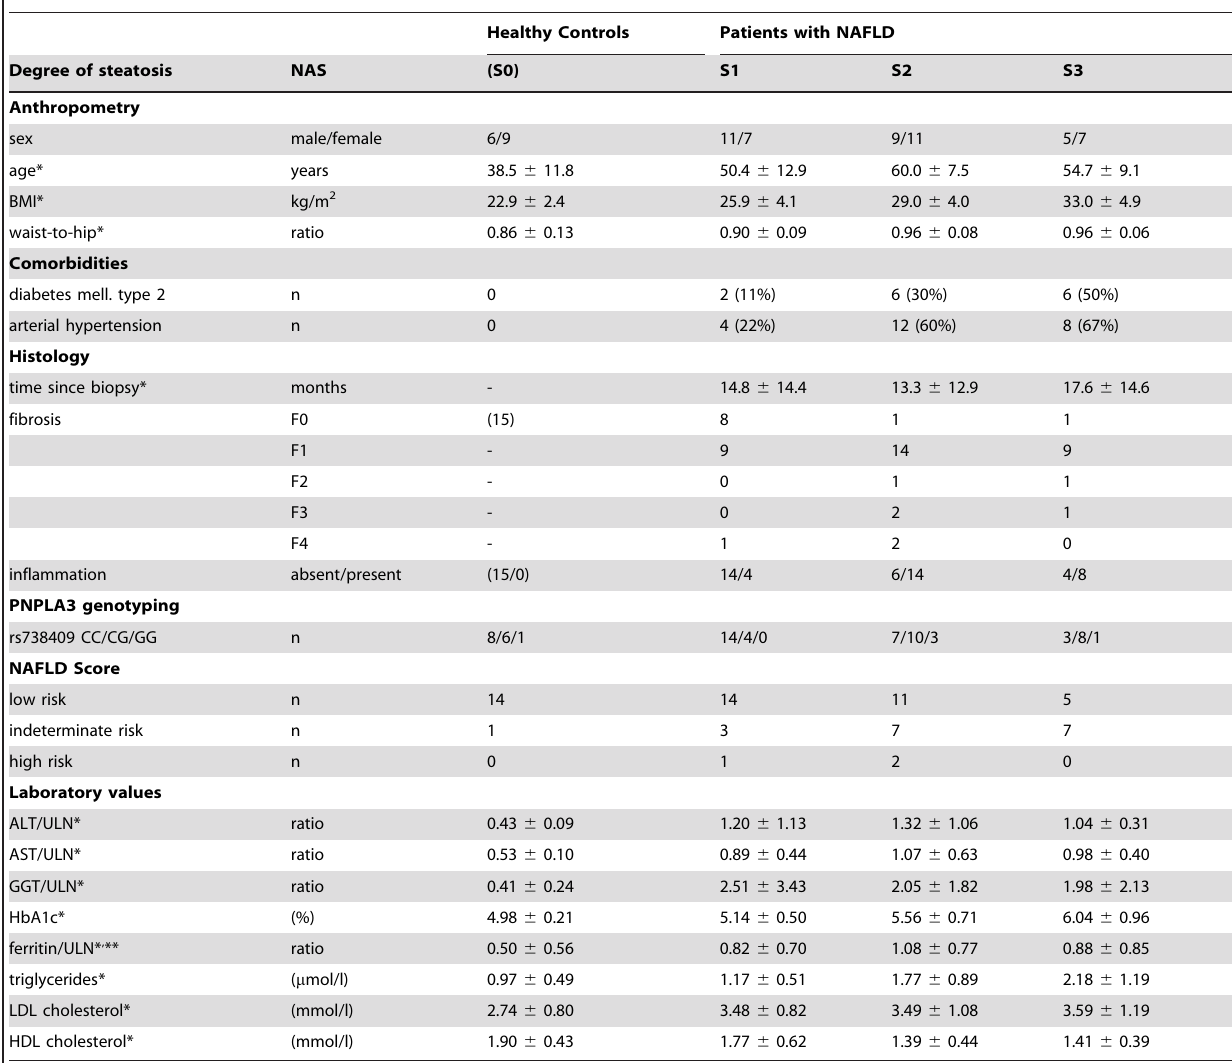
Table 1. Baseline characteristics of the study cohort.